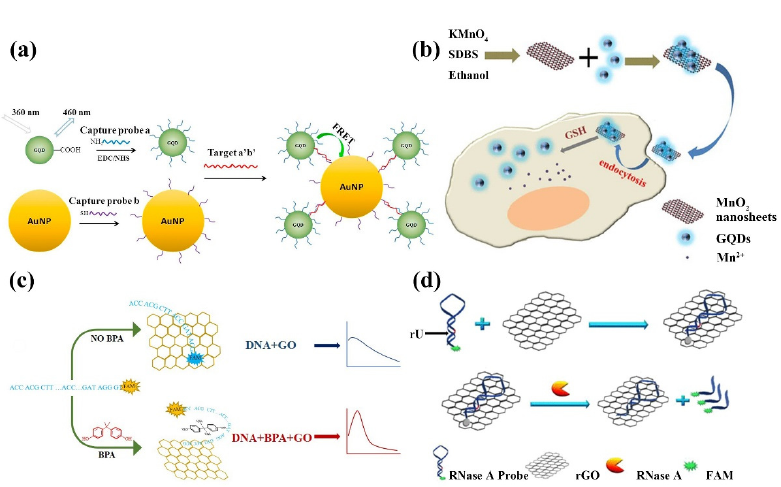
Figure 11. ( a ) Schematic illustration of a FRET assay or the detection of Staphylococcus S. aureus gene between graphene quantum dots and gold nanoparticles. Reprinted with permission from